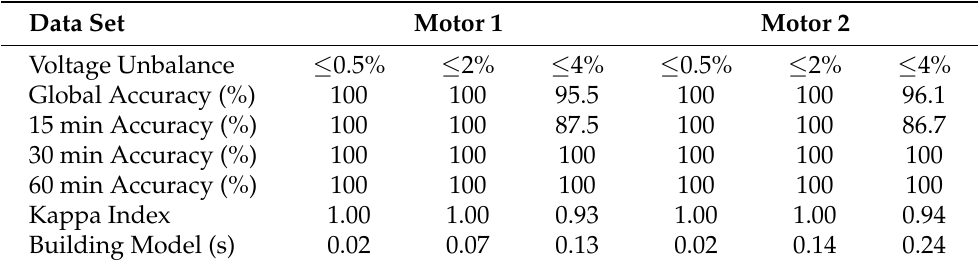
Table 10. Experimental results using PCA for reducing the SMI attributes—Severity analysis of bearing